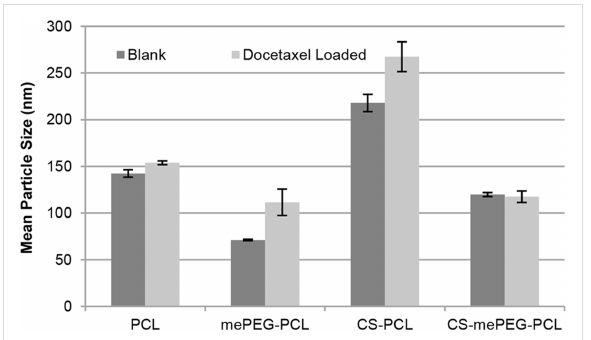
Figure 1: Particle size of blank and drug-loaded nanoparticles ( n = 3, ± SD).